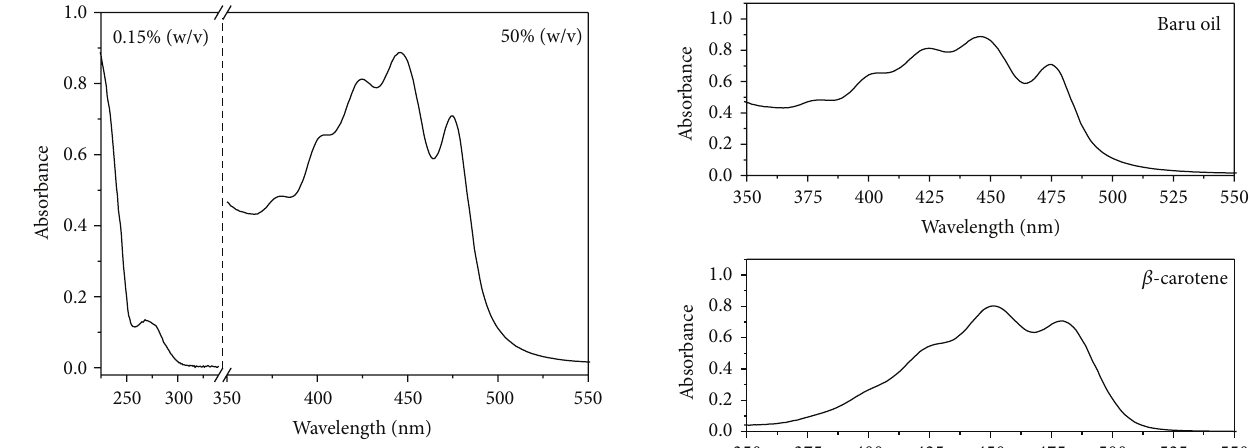
Figure 1: Baru oil absorbance spectrum collected from a diluted sample. The oil was diluted in hexane, and a more concentrated sample was used to better determine the absorption bands in the 350–550 nm range (see text).